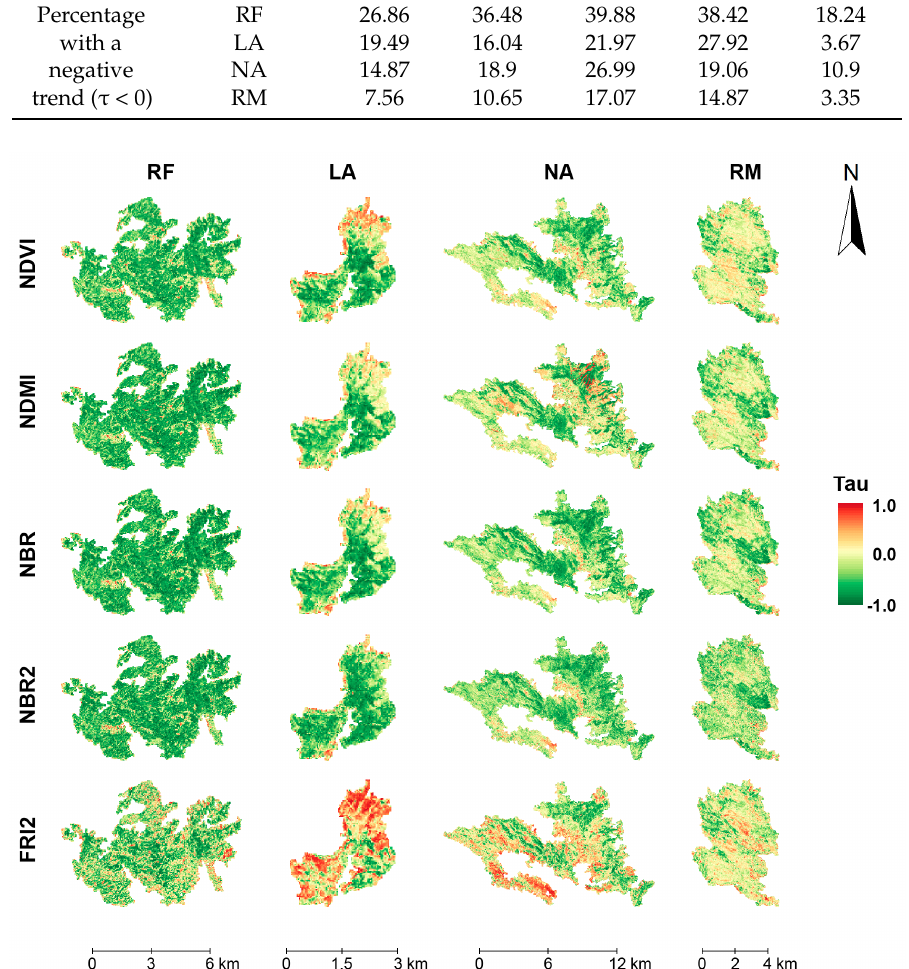
Figure 5. Maps of Kendall’s tau rank correlation coefficient relative to RDSVI trends obtained with the Mann–Kendall test. Kendall’s tau values range from 1 to − 1. Positive values of tau are related to declining trends, whereas negative trends highlight spectral recovery. Study areas are Roccafluvione (RF), Navelli (NA), Roccamorice (RM), and L’Aquila